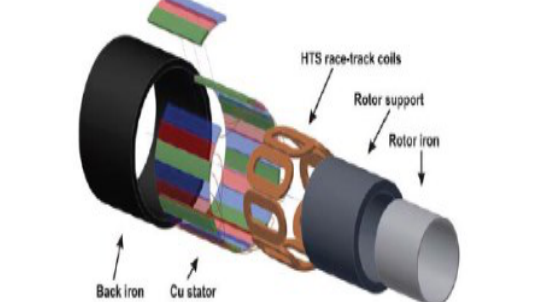
Fig.1 A superconducting multi-pole generator. Reproduced from Courtesy of